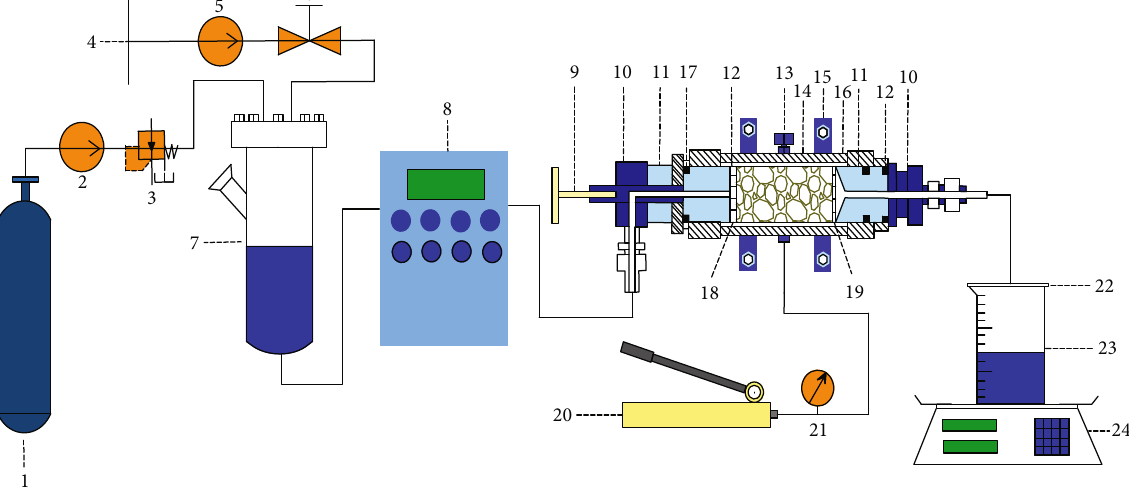
Figure 2: Schematic diagram of permeability test for broken rock